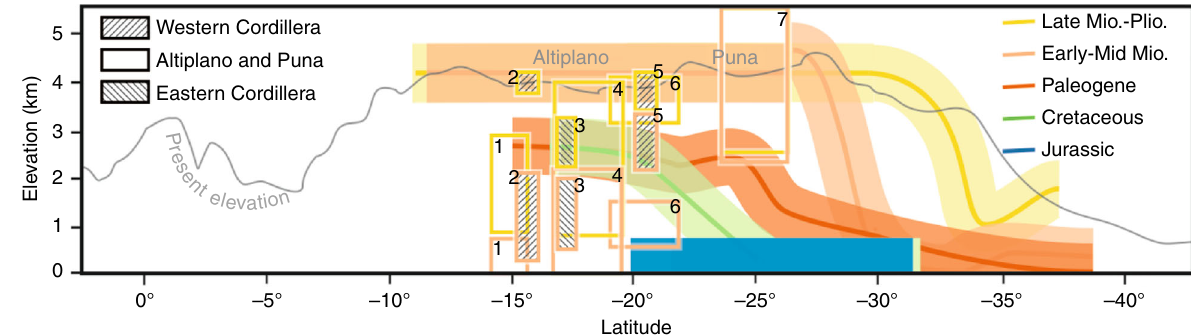
Fig. 6 Surface uplift of the Central and Southern Andes from Jurassic to present. Coloured lines are our inferred regional palaeoelevation estimates for the Western Cordillera using our Sr isotope plateau discriminant and SVZ calibration. Past plateau elevation is inferred to be similar to present-day Western Cordillera elevations (4200 ± 516 m, mean CVZ volcano elevation ±2 SD, using 37.5 km smoothing). Non-plateau palaeoelevation estimates have lines set to a thickness representing 95% con fi dence (±564 m). For general comparison, previously published palaeoelevation estimates are shown in boxes, simpli fi ed to fi t the same time intervals used in this study (1 20 , 2 59 , 3 19 , 4 17, 18 , 5 76 , 6 21 and 7 14